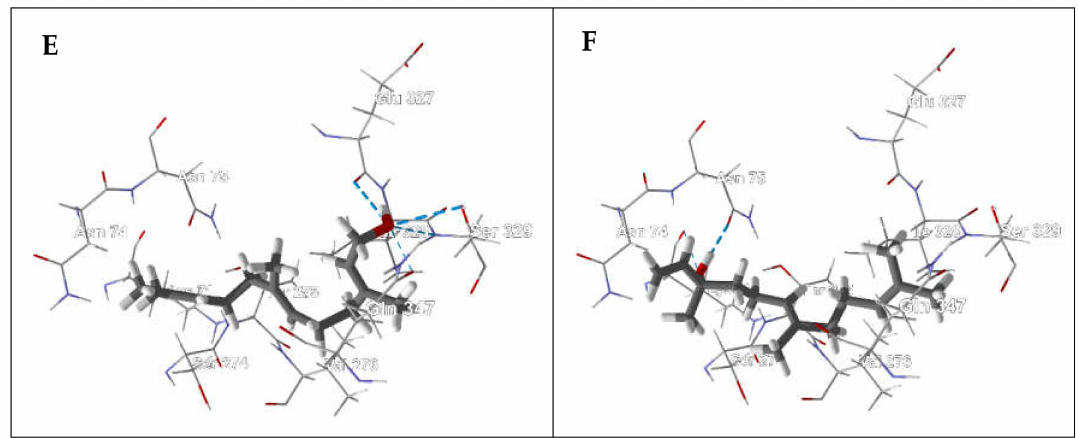
Figure 3. Lowest-energy docked poses of ( E , E )- α -farnesene, ( E )- β -farnesene, ( E , E )-farnesol, and ( E )-nerolidol with SARS-CoV-2 endoribonuclease (PDB: 6VWW). ( A ) Ribbon structure of the enzyme and ( E , E )- α -farnesene (green), ( E )- β -farnesene (aqua), ( E , E )-farnesol (magenta), and ( E )-nerolidol (orange). ( B ) Solid structure of the enzyme showing ( E , E )- α -farnesene (green), ( E )- β -farnesene (aqua), ( E , E )-farnesol (magenta), and ( E )-nerolidol (orange) in the binding cleft. ( C ) Lowest-energy docked pose of ( E , E )- α -farnesene in the binding site. ( D ) Lowest-energy docked pose of ( E )- β -farnesene in the binding site. ( E ) Lowest-energy docked pose of ( E , E )-farnesol in the binding site. ( F ) Lowest-energy docked pose of ( E )-nerolidol in the binding site. Hydrogen bonds are indicated with blue dashed lines. ADP ribose phosphatase (ADRP) serves to convert ADP-ribose 1”-monophosphate (Appr-1”-p)